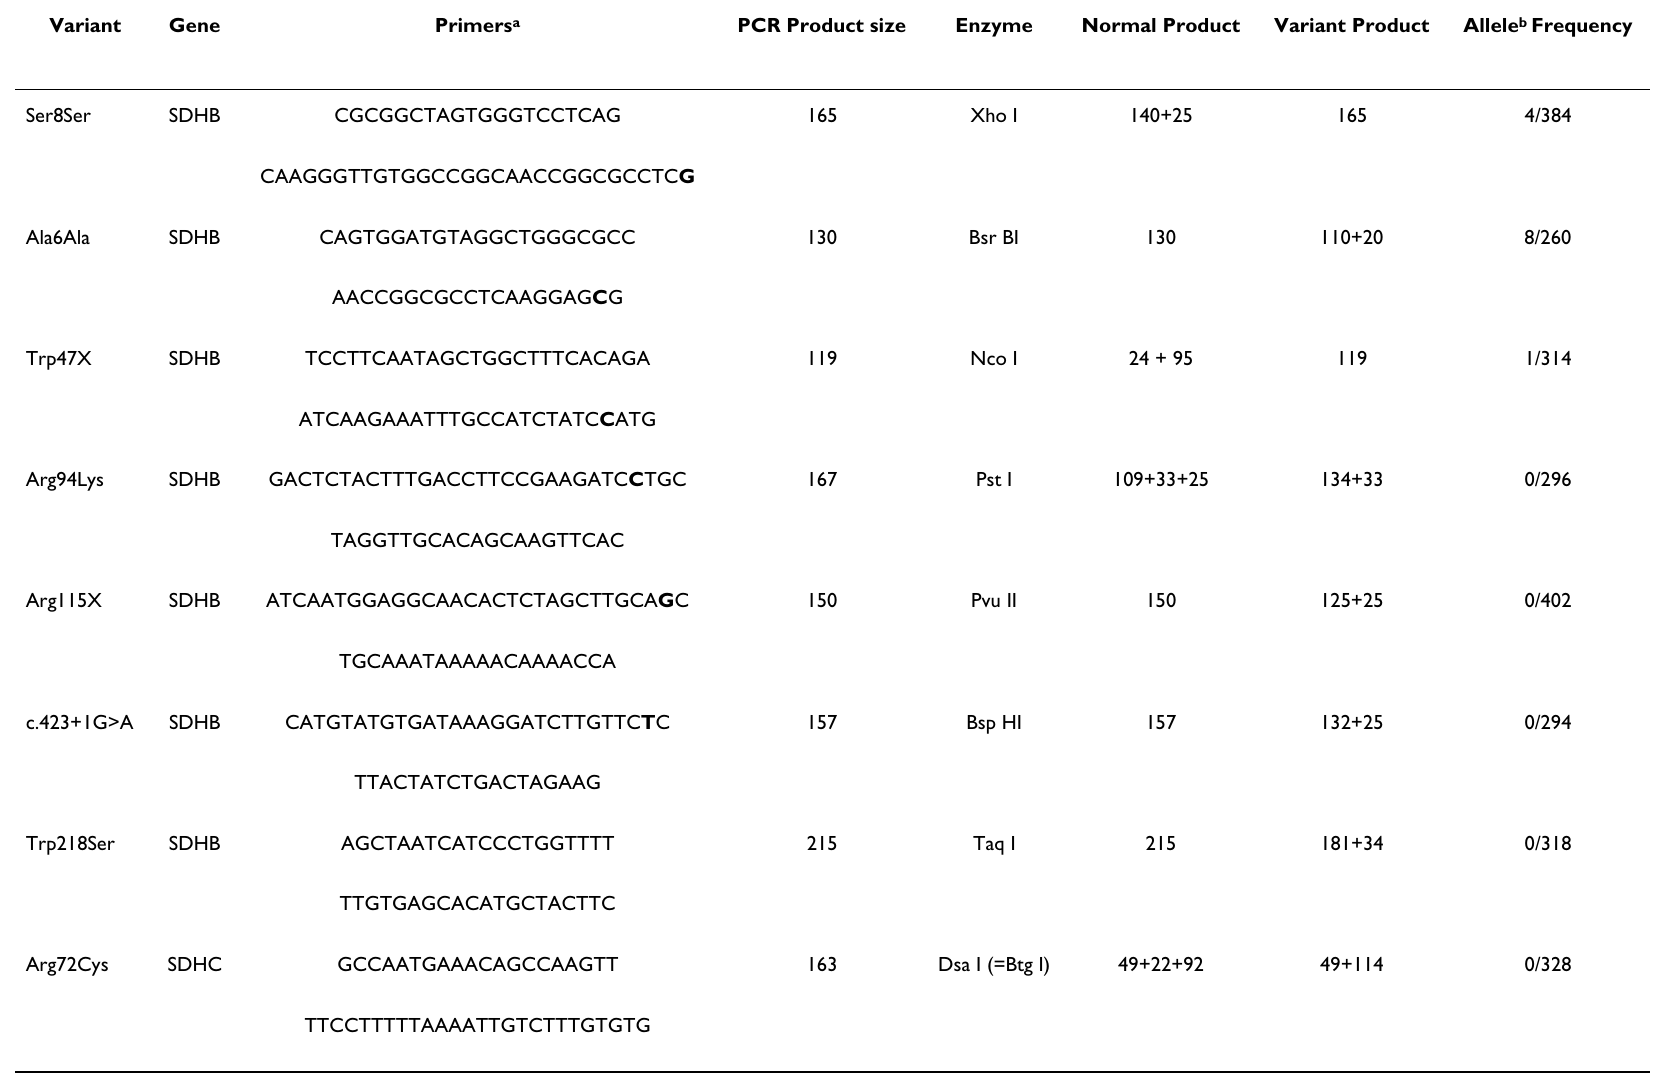
Table 1: Variants/mutations of SDHB and SDHC with primers, restriction enzymes, PCR restriction products, and allele